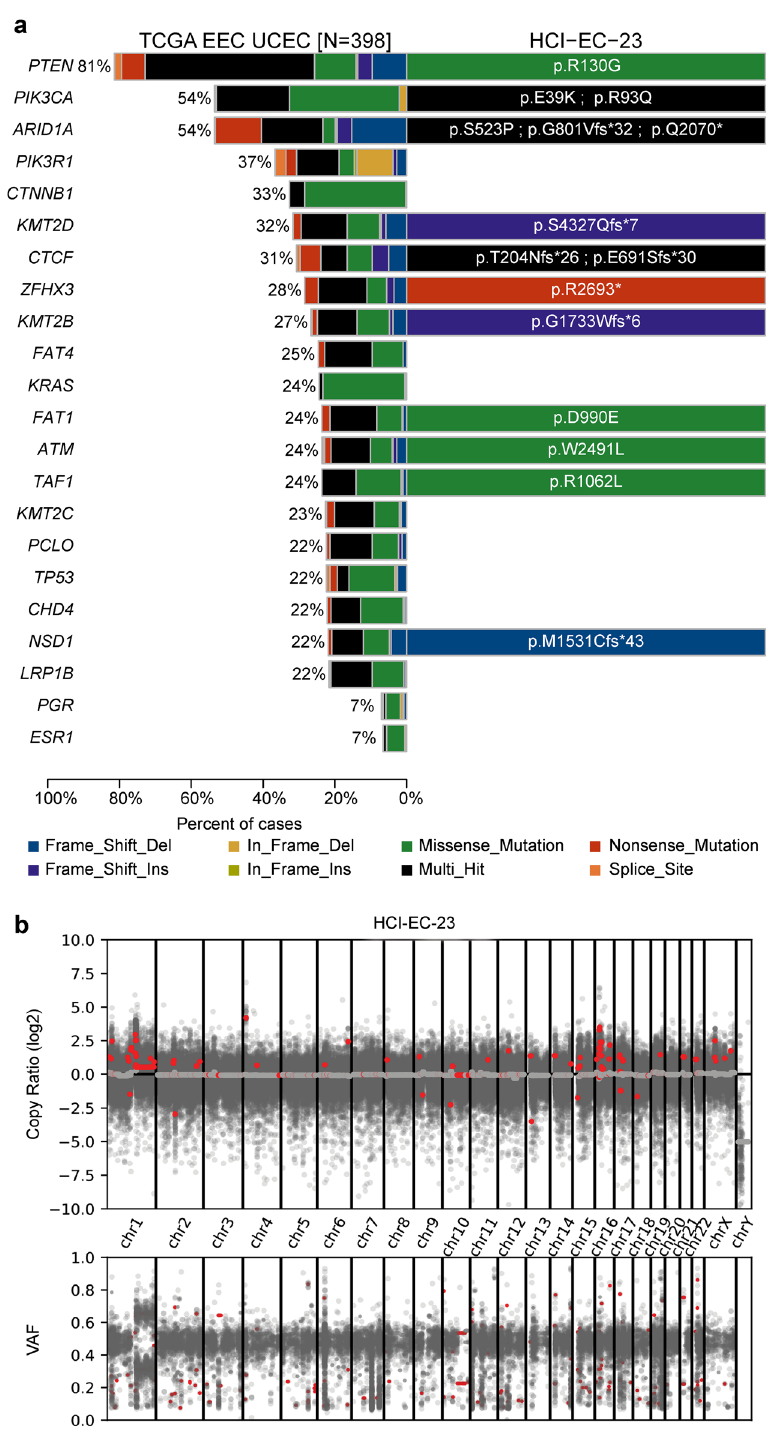
Figure 2. Whole-exome sequencing of HCI-EC-23. (a) Displayed is a comparison of the 20 most frequently mutated genes in the TCGA EEC UCEC cohort along with the hormone receptors PGR and ESR1 (left) and mutations identified in HCI-EC-23 (right). Shown are the protein alterations for each gene in HCI-EC-23. (b) Plot of log 2 copy ratio (top) and variant allele frequency (VAF) along the genome for HCI-EC-23 is shown as computed using CNVKit. The median log 2 copy ratio for each computed segment is shown in